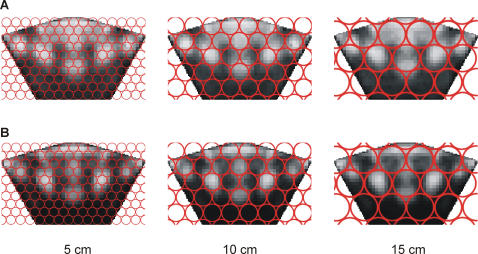
The theoretical perception of average colour patterns by Uca capricornis.The dorsal view of the carapace has been projected onto the ommatidial array (indicated by the red circles), for viewing distances of 5, 10 and 15 cm. The various colour patches of both females (a) and males (b) are theoretically distinguishable at 5, 10, and 15 cm.